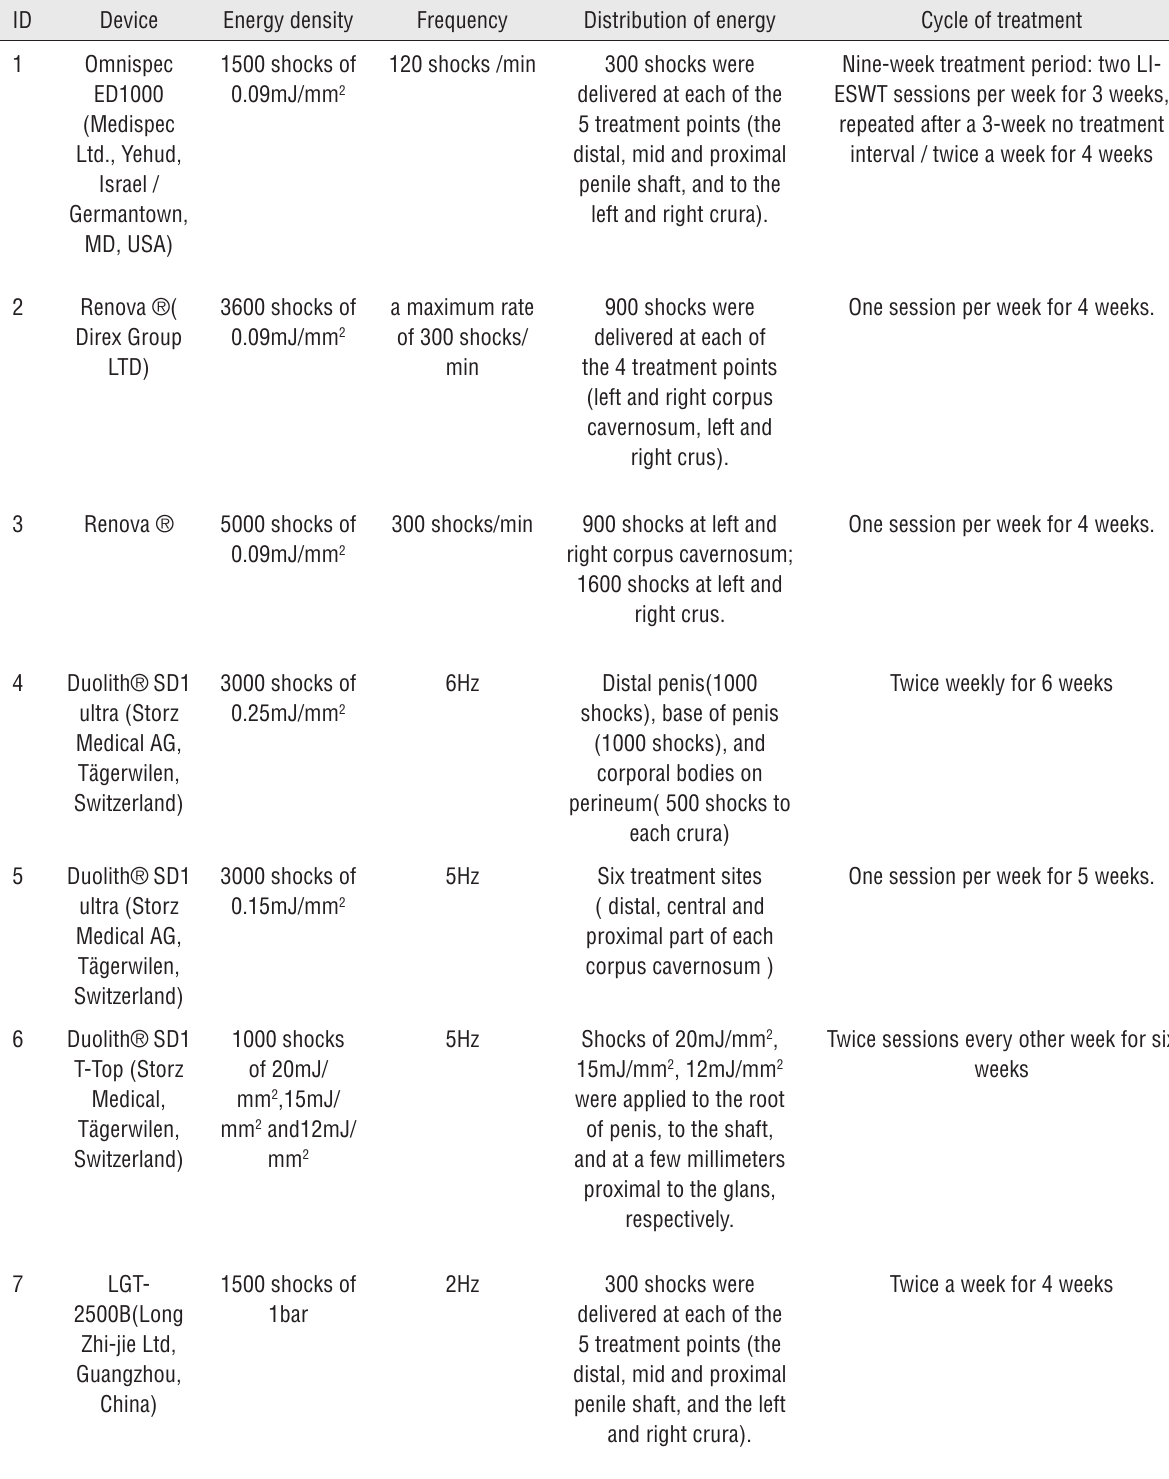
Table 2-The reported protocols of LI-ESWT in included